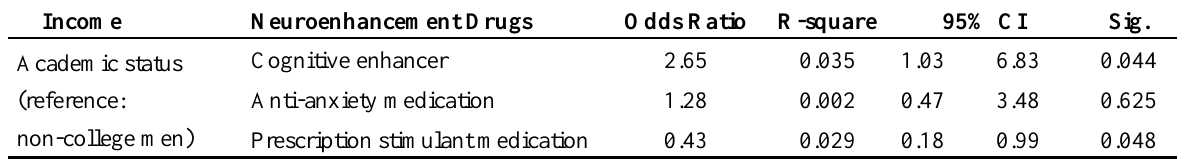
Table 2. Associations between neuroenhancement drug use and academic status.